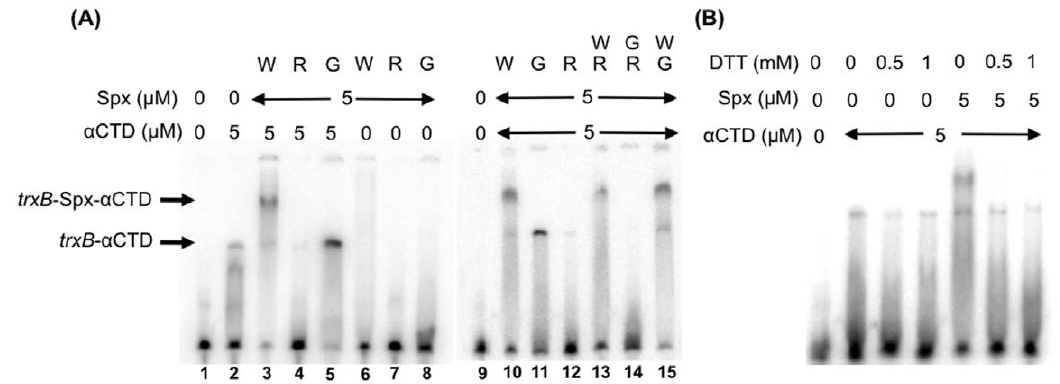
Figure 7. Interaction of a CTD and Spx variants with the regulatory region of the trxB promoter. The trxB probe ( 2 56 to 2 21) was generated by annealing of oligonucleotides followed by labeling of the 3 9 -end of the template strand using Klenow fragment and [ 32 P]dATP. Bands corresponding to the trxB / a CTD and trxB /Spx/ a CTD complexes are marked with arrows. (A) EMSA analysis of a CTD and Spx binding to the trxB probe in reactions containing Spx variant or mixtures of mutant Spx proteins or mutant with the wild-type Spx (each at 5 m M). Abbreviations: W, wild-type Spx; G, Spx G52R ; R, Spx R60E . (B) Redox-sensitive interaction was examined in the presence of DTT.